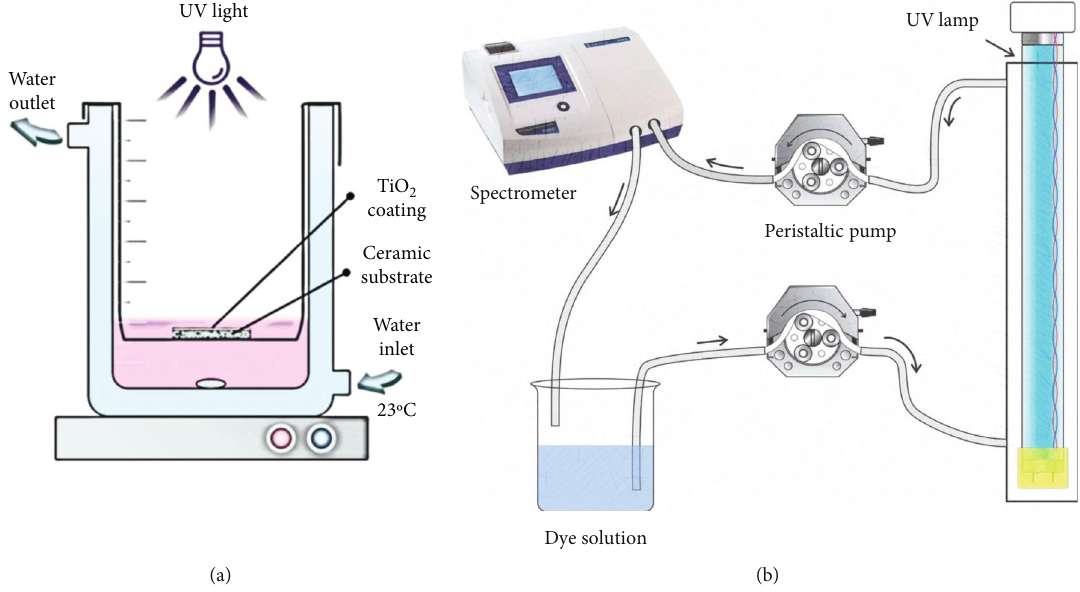
Figure 3: (a) Batch process setup vs. (b) continuous process setup for photocatalytic degradation of dye.